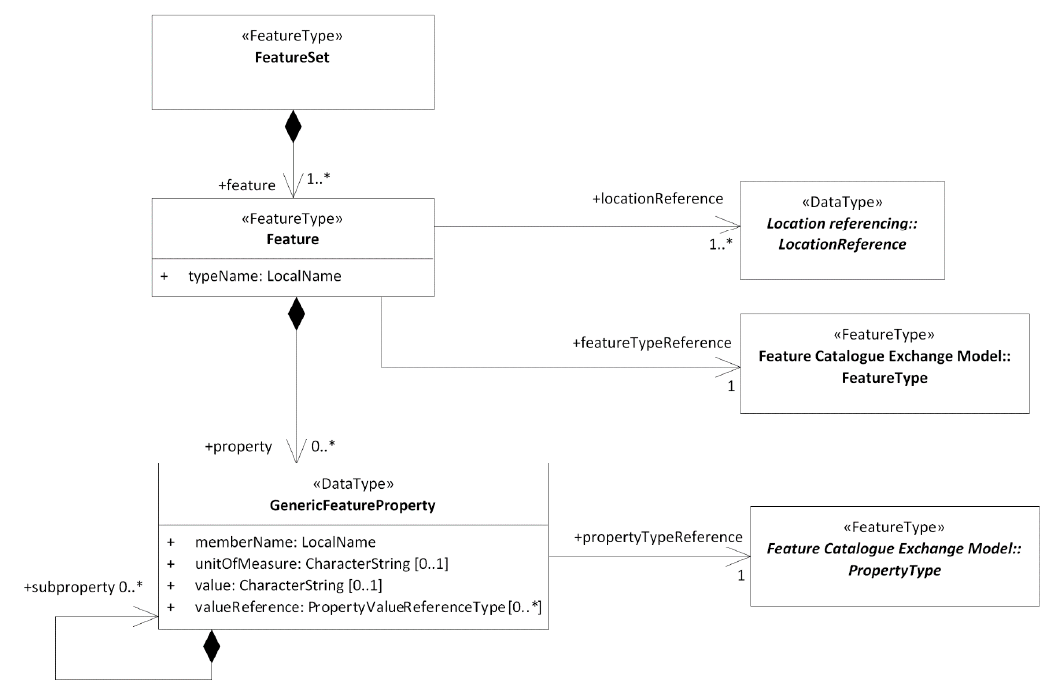
Figure 7. The Feature Model in the prototype.